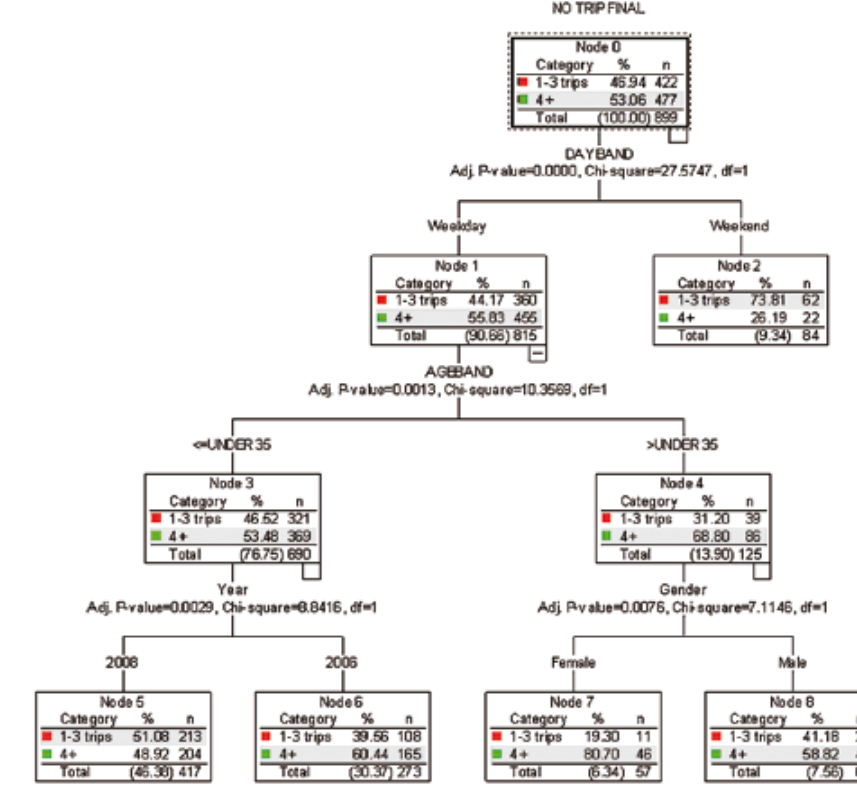
Fig. 2. Answer tree – what conditions influence the number of physical trips per